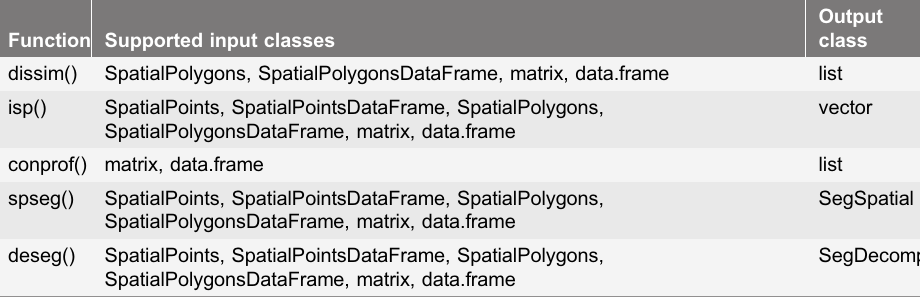
Table 2. Supported input and output classes for the implemented